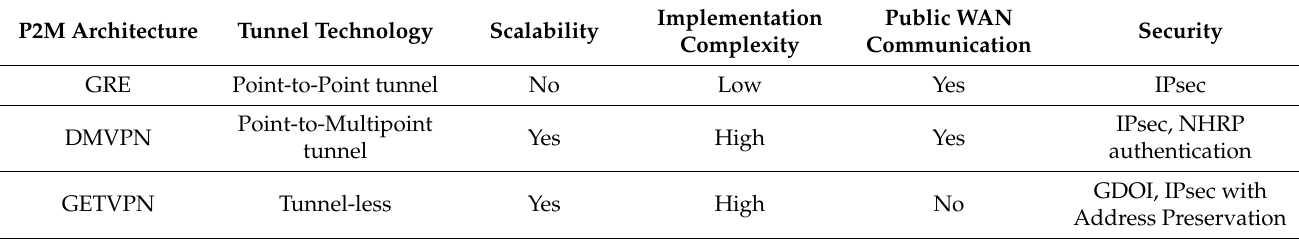
Table 5. Comparing characteristics of P2M